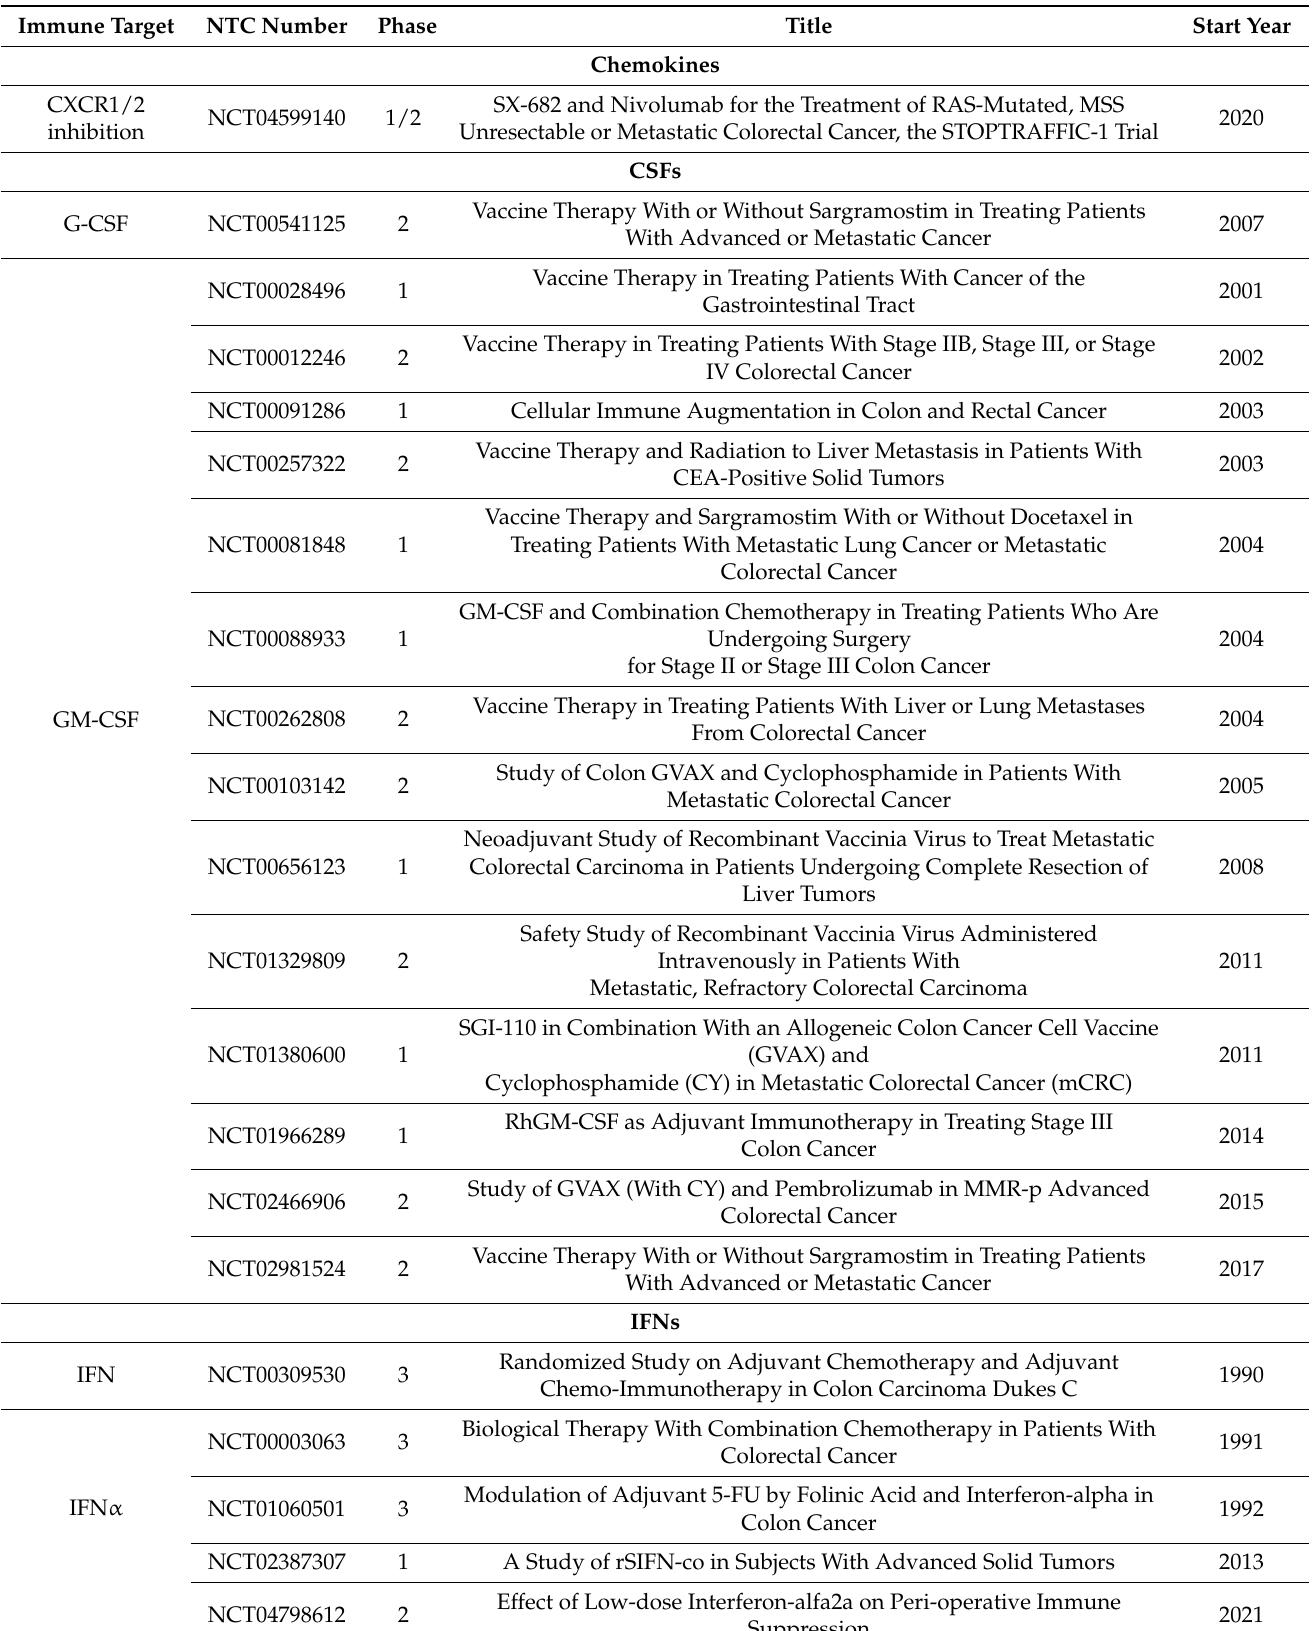
Table 1. Examples of clinical trials using cytokine-based immunotherapy for colorectal